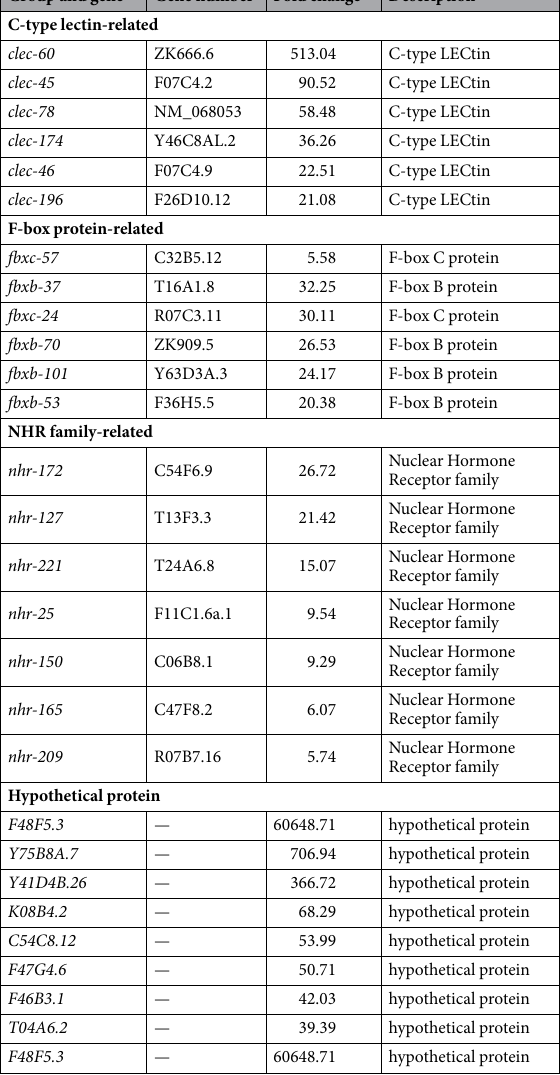
Table 1. List of differentially expressed genes ( > 5.0 folds) in Caenorhabditis elegans fer-15;fem-1 worms